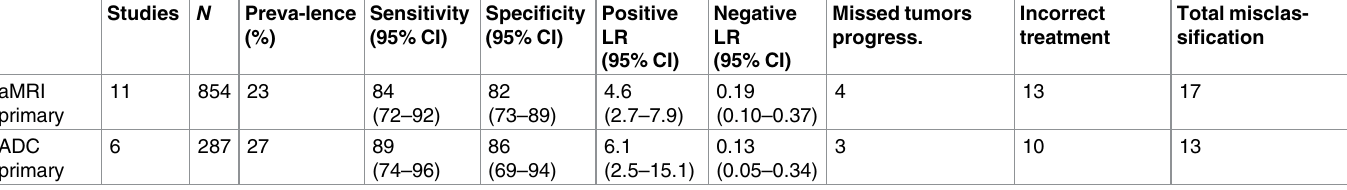
Table 3. Pooled diagnostic accuracyresults.